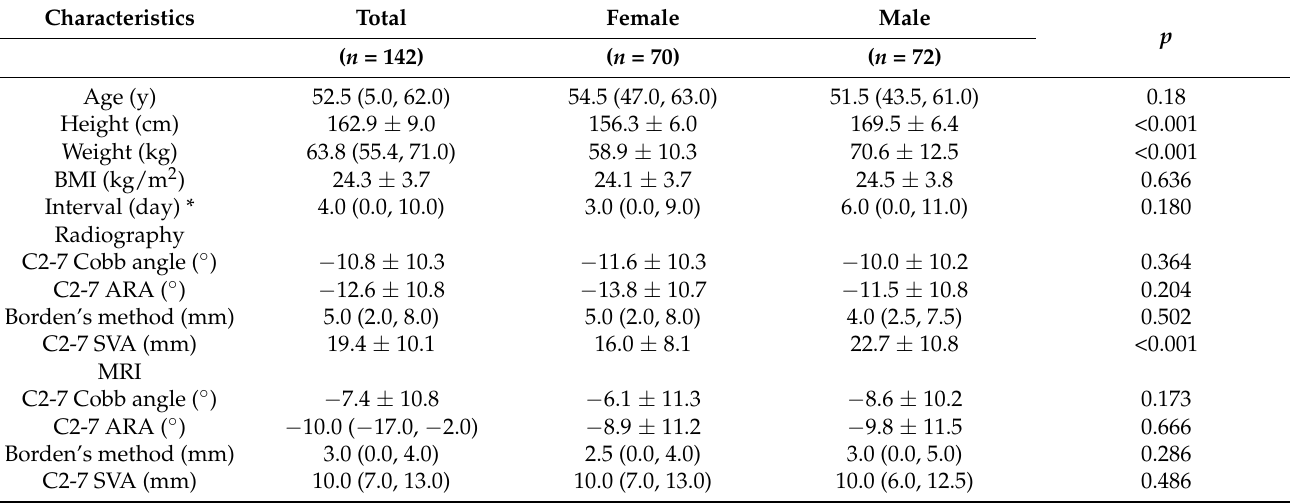
Figure 2. Patient flow diagram. Table 1. Patient characteristics.